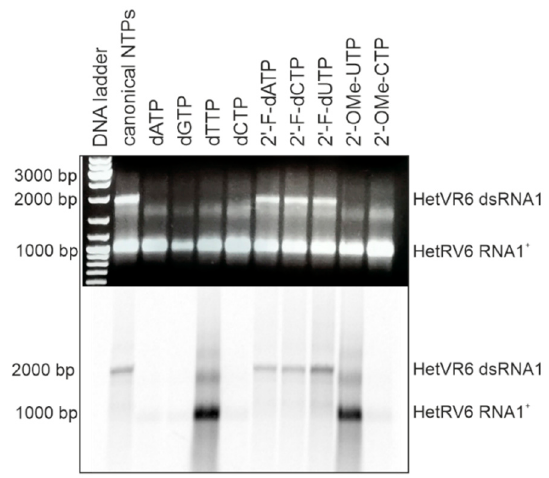
Figure 5. HetRV6 RdRp ability to use modified NTPs as a substrate for the RNA-directed synthesis of a (-)RNA strand. One of the NTPs in polymerase reaction was replaced by its modified analogue, and a standard polymerase reaction with [ α - 33 P]-UTP was incubated 1.5 h at 30 ◦ C. Native agarose gel is on the top, and autoradiogram of the same gel is shown at the bottom. The mobility of the template HetRV6 RNA1 + and the dsRNA1 product are indicated on the